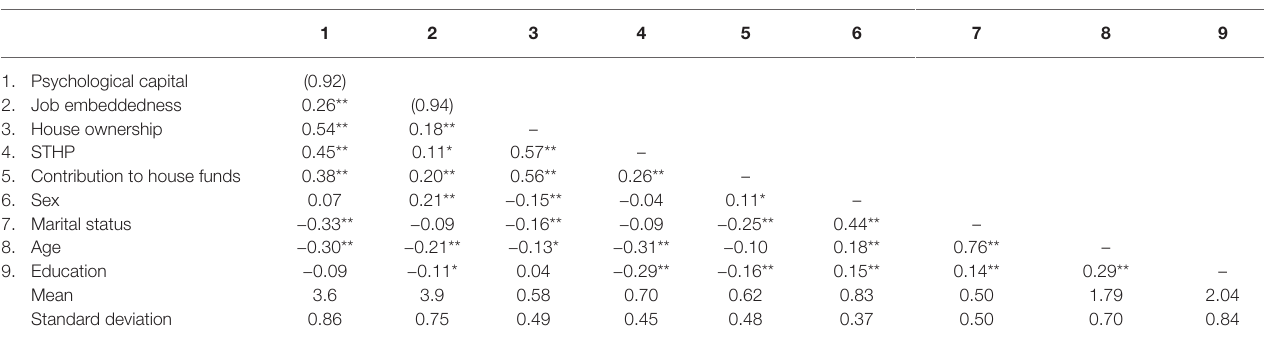
TABLE 1 | Means, standard deviations, Cronbach’s α , and Pearson bivariate correlations of the study